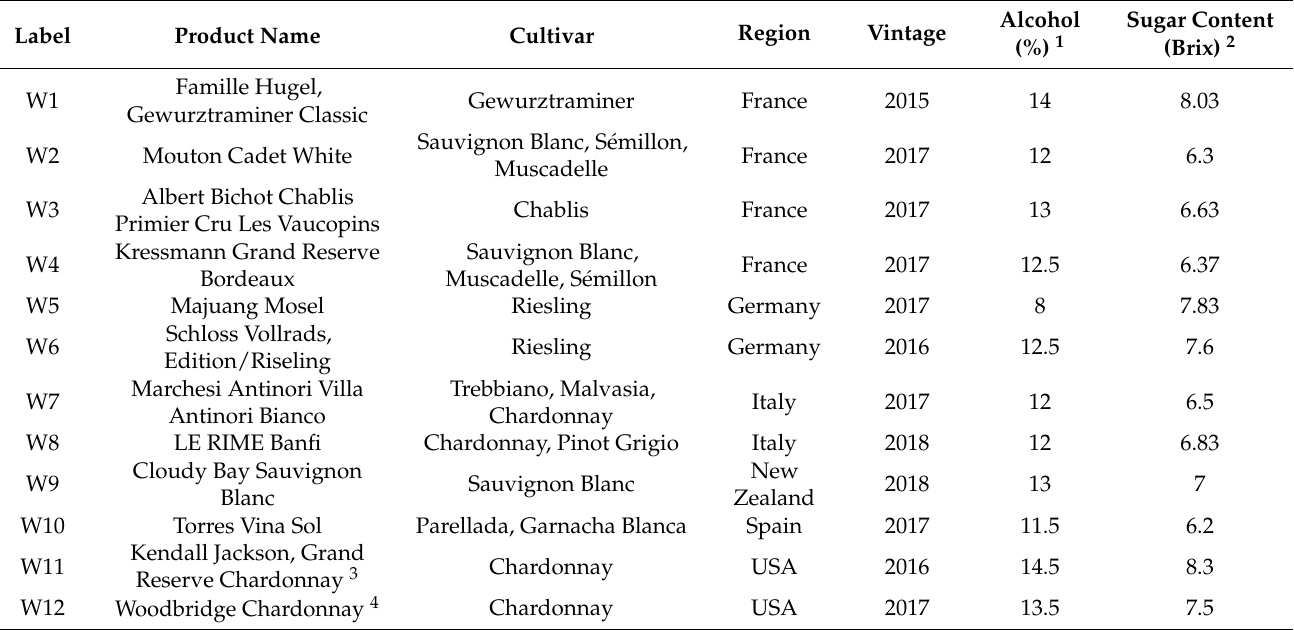
Table 1. Information of 12 white wine samples